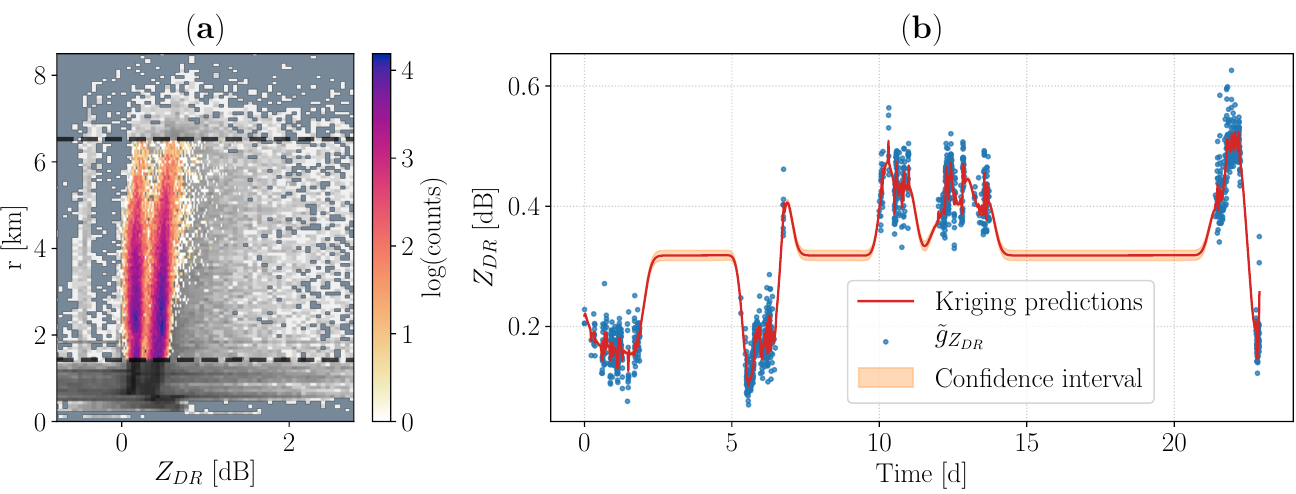
Figure 6. Calibration of the radar DX50 for the PAYERNE campaign. ( a ) The 2-dimensional histograms of the couples ( t , Z ) computed over the original dataset (grayscale) and over the region of the profiles suitable for extracting the median DR ( r ) (in color, with colorbar on the right). The horizontal dashed lines delimit this chosen region. ( b ) Evolution values ˜ f Z k , u DR in time of the bias. Content analogous to Figure